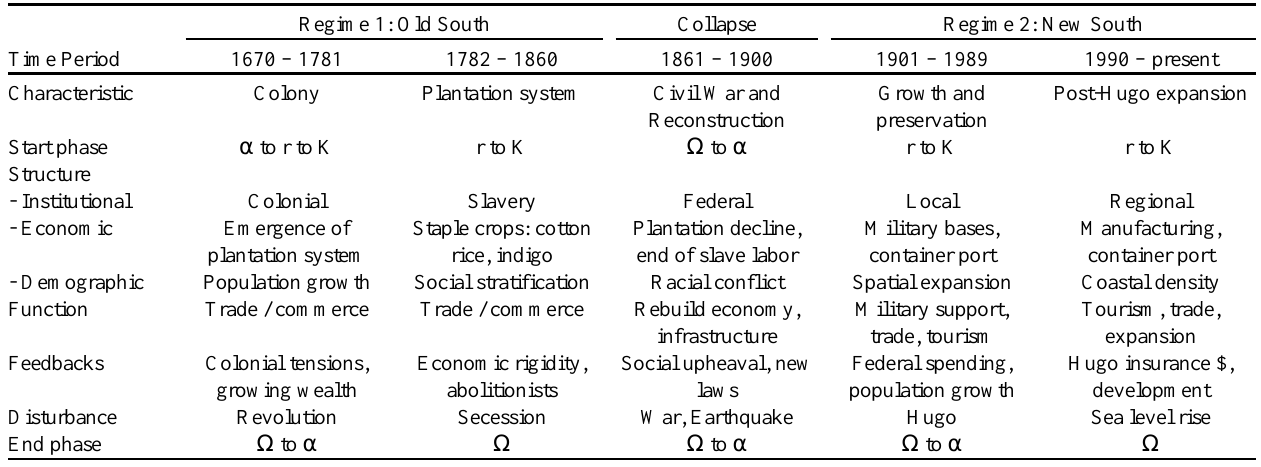
Table 1. System characteristics, adaptive cycles, and regime change in Charleston, South